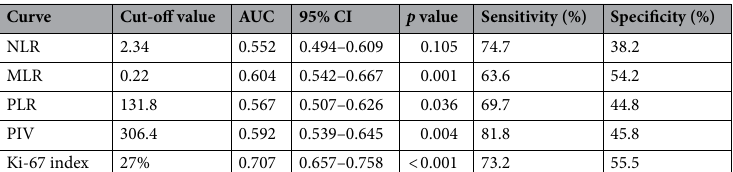
Table 2. Receiver operating characteristic curve analyses for pathological complete response. AUC the area under the curve, CI confidence interval, NLR neutrophil-to-lymphocyte ratio, MLR monocyte-to-lymphocyte ratio, PLR platelet-to-lymphocyte ratio, PIV pan-immune-inflammation-value.